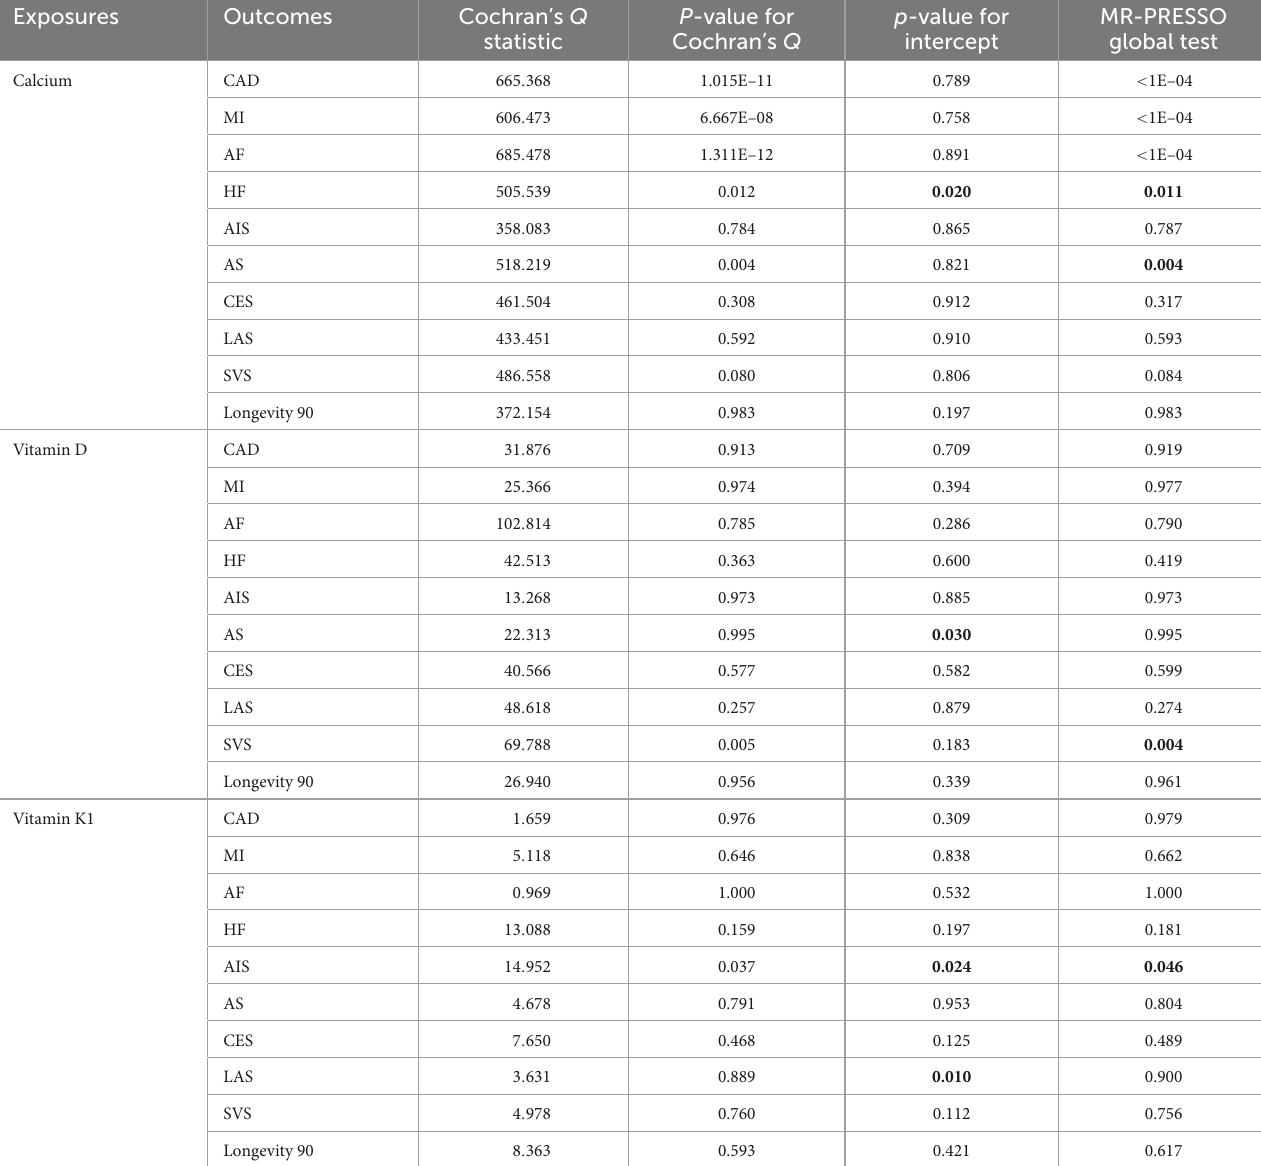
TABLE 2 Results of potential pleiotropy and heterogeneity